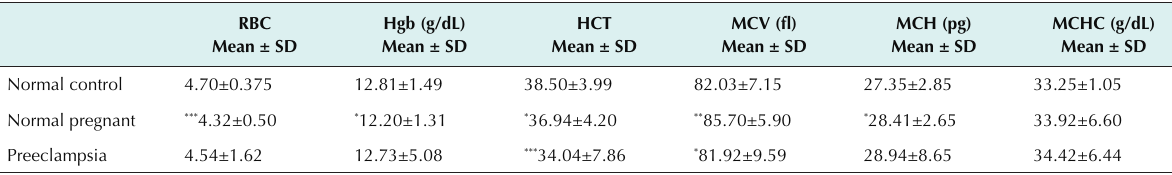
Table 2. Erythrogram in Normal Control, Normal Pregnancy, and